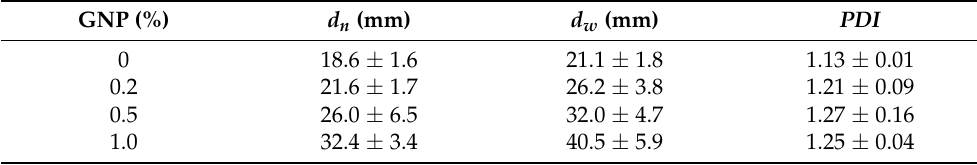
Table 3. d n , d w and PDI s of the asphalt particles in GNP-reinforced EABCs.